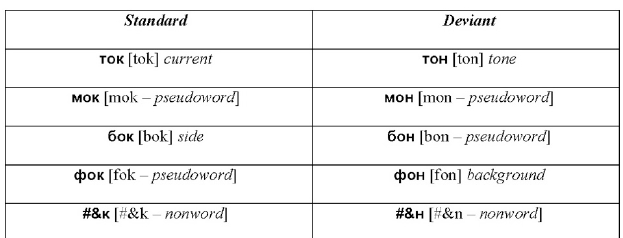
Table 1 | Visual word, pseudoword and non-word stimuli used in oddball sequences (Latinized transcription in square brackets, English translation in